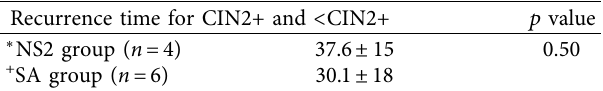
Table 4: Time to recurrence of CIN lesions following treatment of CIN2+ or detection of < CIN2 in women who received the human papilloma virus vaccine at the Women’s Health Center (WHC) of the American University of Beirut-Medical Center (AUBMC)